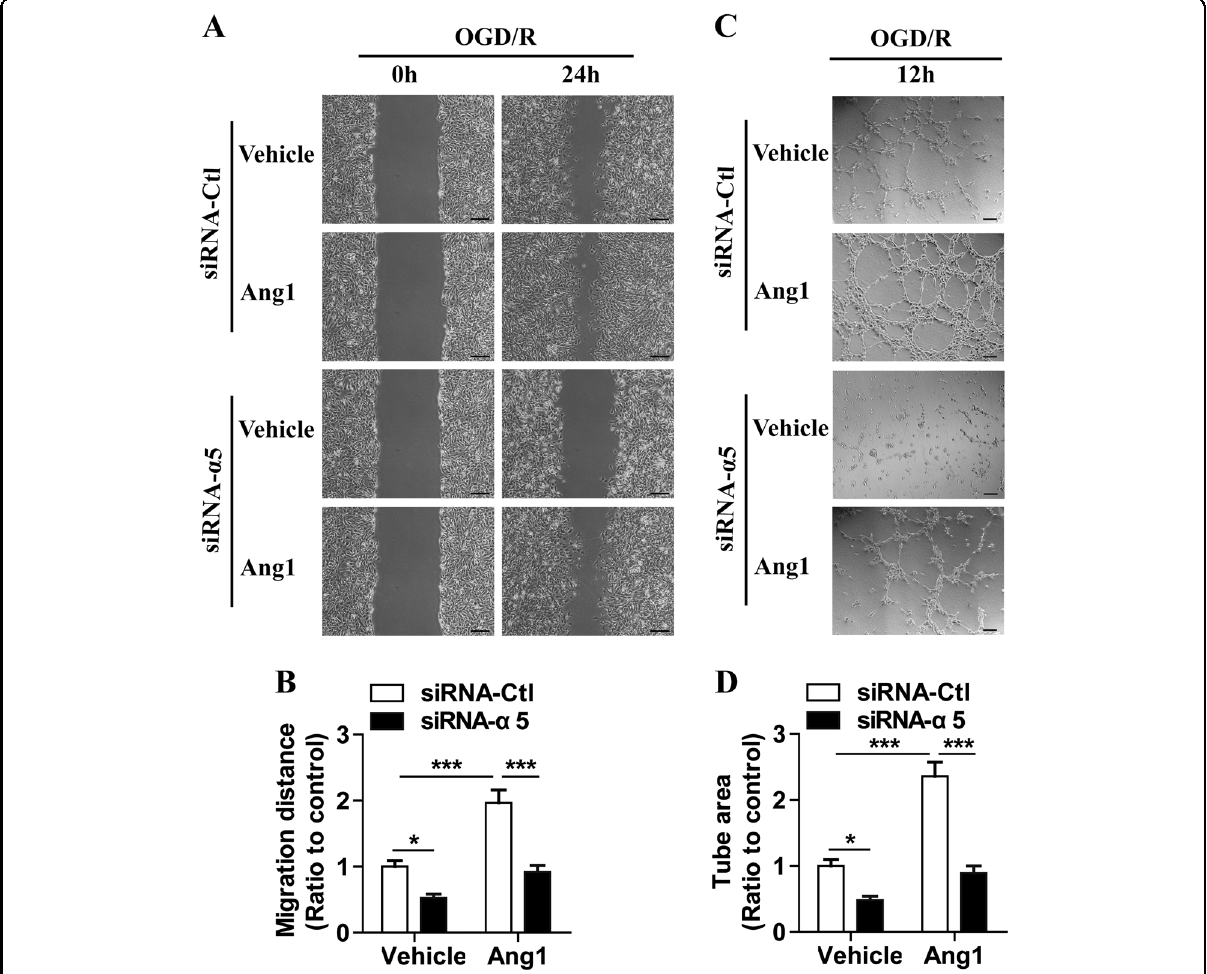
Fig. 7 Ang1-induced BEC migration and tube formation after OGD is mediated by integrin α 5. BECs were transfected with siRNA-Ctl or α 5 integrin-speci fi c siRNA (siRNA- α 5), and then, cell migration and tube formation were measured after transfected BECs were subjected to 4 h of OGD. a Representative images of cell migration in monolayer cultured BECs in the absence or presence of Ang1 (100 ng/mL) as indicated, scale bar = 200 μ m. b Quanti fi cation of BEC cell migration. The relative migration distance was quanti fi ed using ImageJ software and expressed as the ratio to the values of the siRNA-Ctl-treated cells (control). c Representative images of capillary tube formation of BECs on Matrigel-coated plates in the absence or presence of Ang1 (100 ng/mL) as indicated, scale bar = 100 μ m. d Quanti fi cation of tube formation. Data represent the mean ± SEM and were analyzed by two-way ANOVA ( n = 3). Note that Ang1 signi fi cantly increased the migration and capillary-like tube formation of BECs after